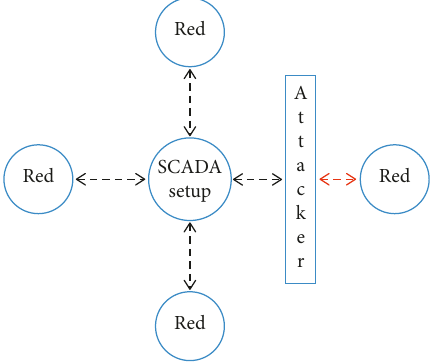
Figure 1: Eavesdropper masquerading the SCADA